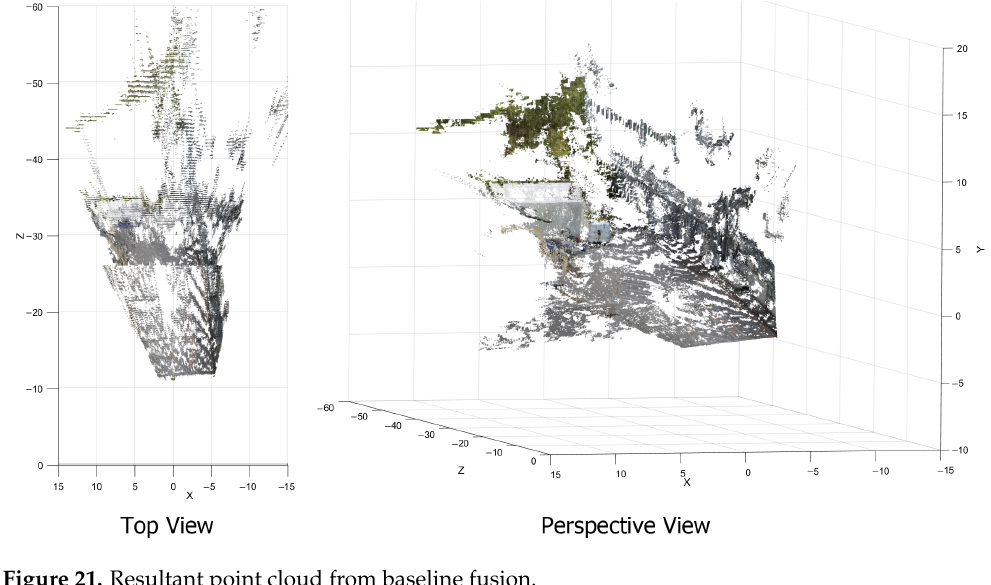
Figure 21. Resultant point cloud from baseline fusion.